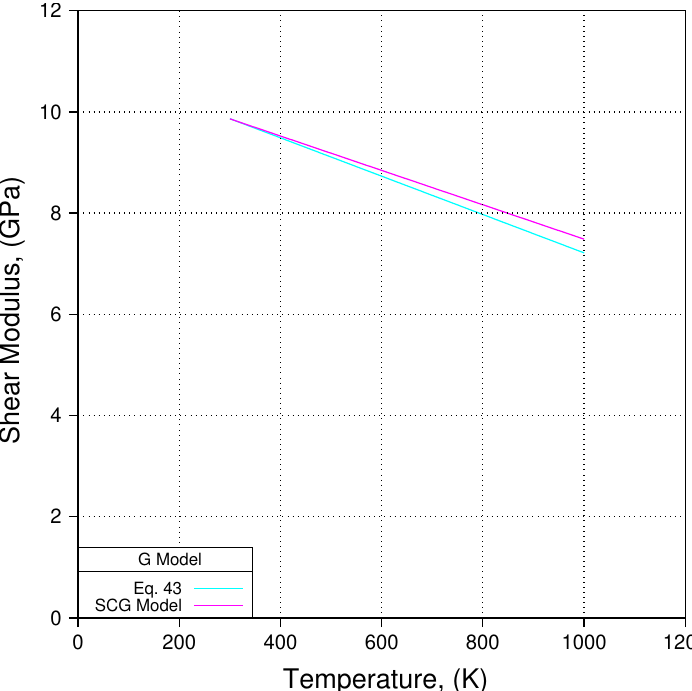
Figure 6. Shear modulus as a function of